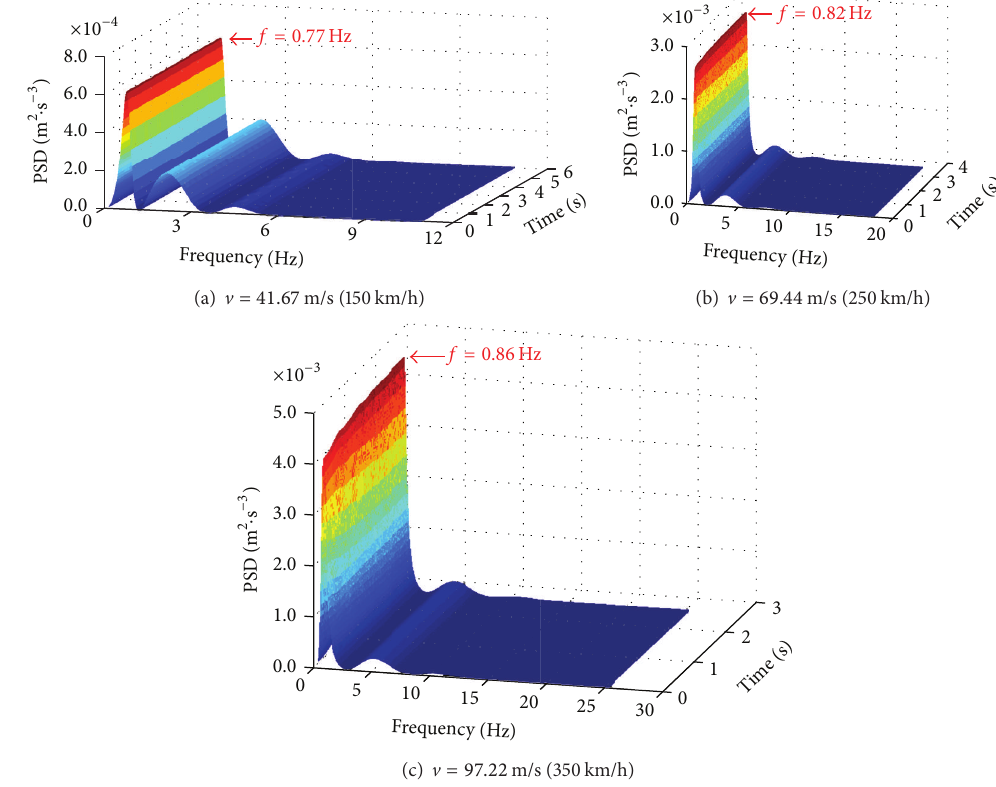
Figure 21: PSD of vertical acceleration of motor